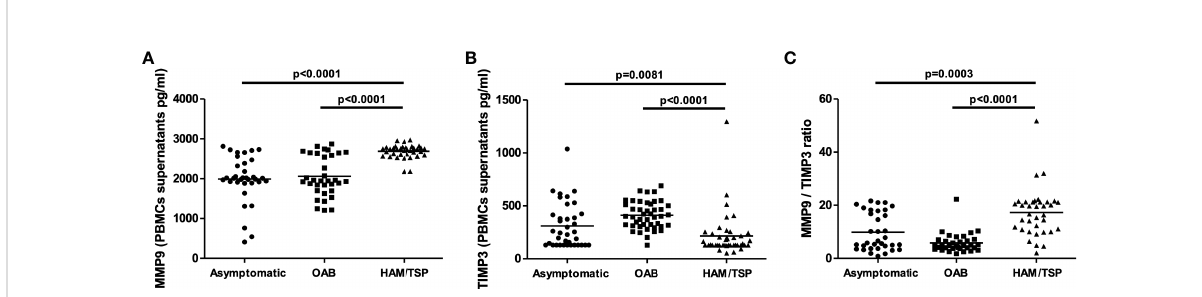
FIGURE 1 HAM/TSP patients present increased MMP-9 levels in PBMC culture supernatants. MMP-9 (A) and TIMP-3 (B) levels in PBMC supernatants from HTLV-1 carriers, OAB-HTLV-infected and HAM/TSP patients, as assayed by ELISA. (C) MMP-9/TIMP-3 ratio. Bars represent median values from each group. Nonparametric testing (Mann-Whitney) was used to compare